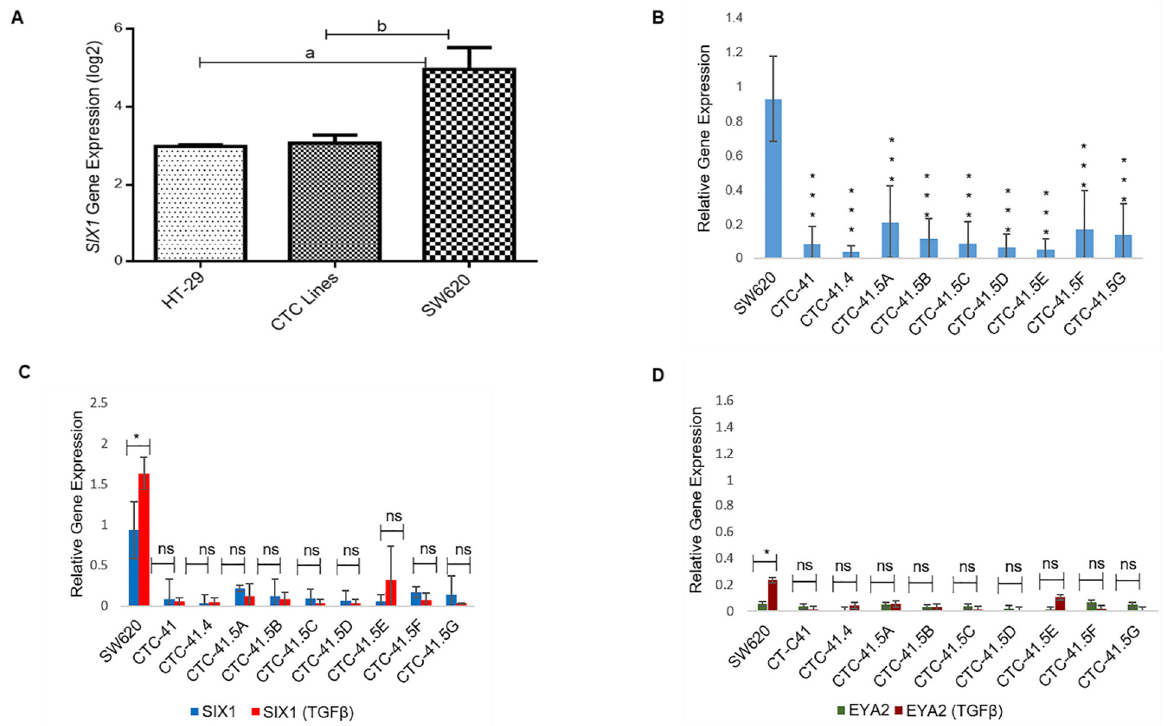
Figure 1. Expression of SIX1 and its co-activator EYA2 in colorectal cancer cell lines in normal culture conditions and after incubation with TGF- β . ( A ) Comparison of SIX1 expression in colon circulating tumor cell (CTC) lines (pooled data), and in primary (HT-29) and metastatic (SW620) colorectal cancer cell lines (microarray data). ( B ) RT-qPCR analysis of SIX1 expression in each of the nine CTC lines and in SW620 cells. ( C ) RT-qPCR analysis of SIX1 expression in cells incubated or not with TGF-β. ( D ) EYA2 expression profile in cells incubated or not with TGF-β. a: p -value = 2.73 × 10 −9 ; b: p -value = 9.80 × 10 − 11 . All the RT-qPCR results were normalized to the B2M expression level in each sample; * p < 0.05, *** p < 0.001, ns: not